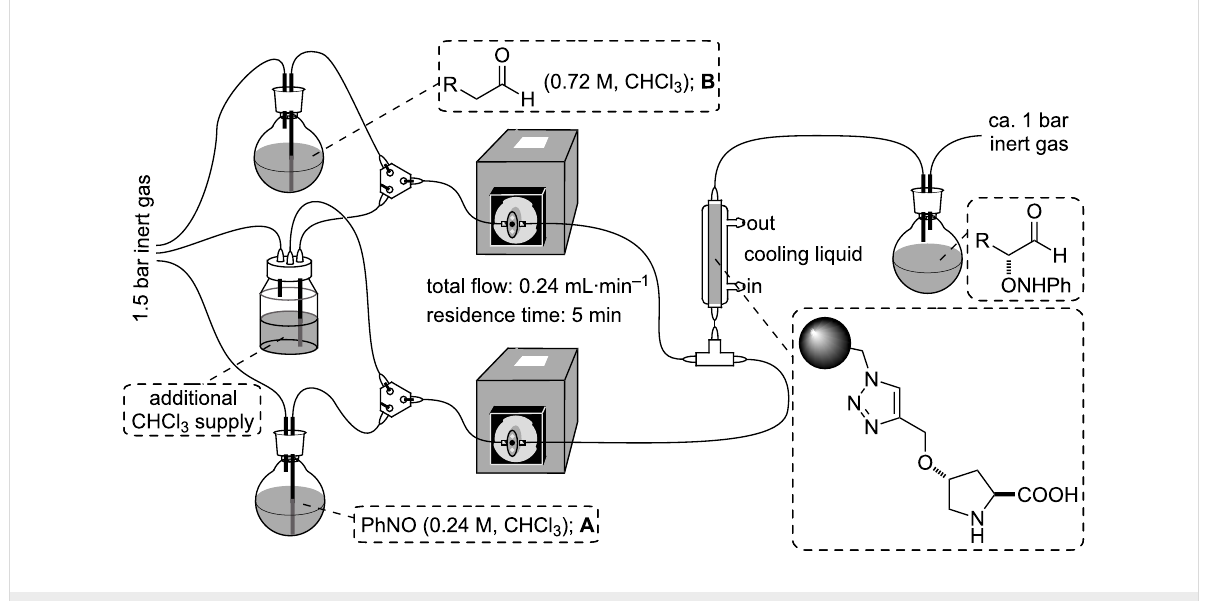
Figure 2: Experimental setup for the continuous-flow α -aminoxylation of aldehydes.